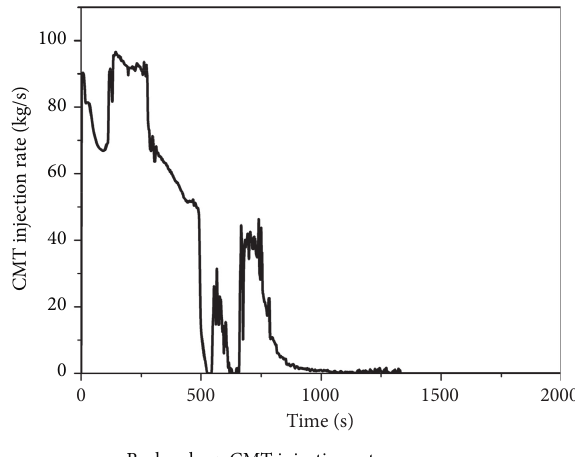
Figure 21: DEDVI line break CMT injection rate.